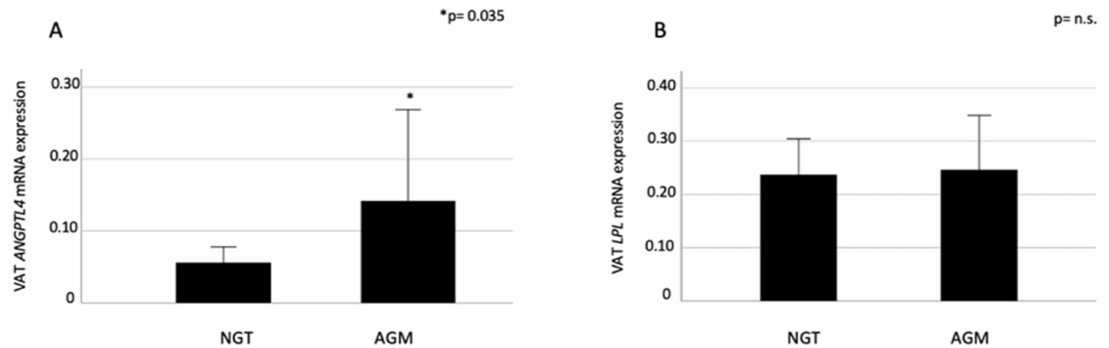
Figure 1. ( A ) Visceral adipose tissue angiopoietin-like protein 4 (VAT ANGPTL4) and lipoprotein lipase (LPL) ( B ) mRNA levels. Comparison between normal glucose tolerance (NGT) and abnormal glucose metabolism (AGM) individuals. * P value ≤ 0.05 is considered statistically significant. Data are shown as median (95% C.I.) values; arbitrary units. n.s., not